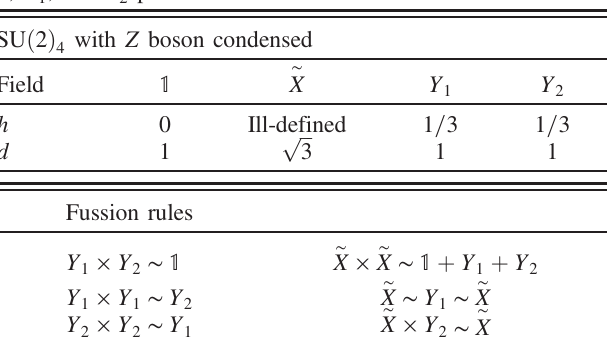
UNIVERSAL TOPOLOGICAL QUANTUM COMPUTATION TABLE III. Field content and fusion rules for SU ð 2 Þ 4 upon TABLE IV. The fields of Fib, along with their corresponding condensing the bosonic Z field listed in Table I. As in the other conformal spin h , quantum dimension d , and nontrivial fusion tables, j is an SU(2) spin label, h denotes conformal spin, and d rule. This TQFT arises from SU ð 2 Þ 3 ⊗ SU ð 2 Þ 1 upon condensing ~ X represents the quantum dimension for each particle. The field is the boson ð ξ ; η Þ in Table II and describes the topologically confined by the condensation and hence exhibits an ill-defined ordered sector of the Fibonacci phase in our ν ¼ 2 = 3 setup. conformal spin; this field obeys the same fusion rules and projective non-Abelian statistics as the (also confined) domain- wall defects in our ν ¼ 2 = 3 trenches. Additionally, Y 1 and Y 2 represent Abelian fields that correspond to charge- 2 e= 3 and 4 e= 3 excitations in our quantum Hall setup. If one ignores the confined ~ X excitation , the remainder is a pure Abelian Z 3 theory with only 1 , Y Y 1 , and 2 particles.